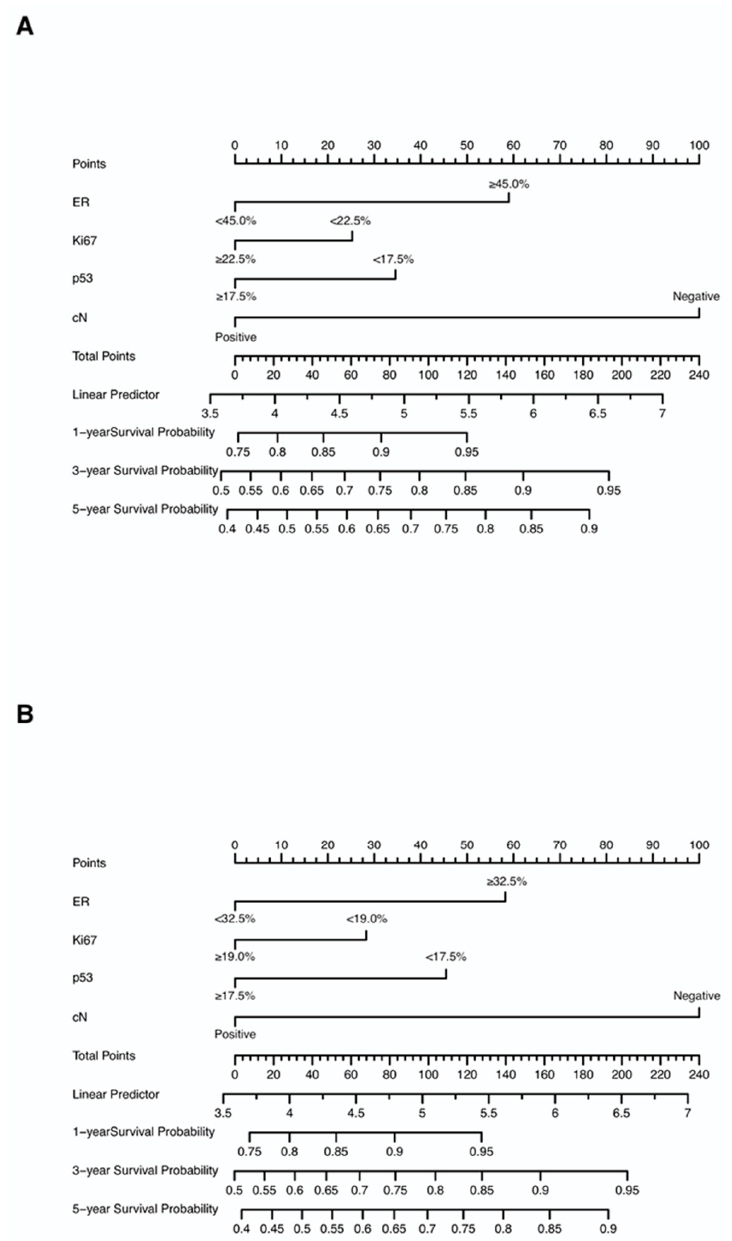
Figure 4. Nomograms predicting the 1-, 3-, and 5-year DFS in non-pCR patients based on ( A ) pre-NAC core needle biopsy and ( B ) post-NAC surgical specimens. Each value of each variable corresponds to some points on the line “Points”; the sum of all points together (Total Points) corresponds to a probability on the lines “1-year Survival Probability”, “3-year Survival Probability”, and “5-year Survival Probability”. Abbreviations: DFS, disease-free survival; pCR, pathologic complete response; NAC, neoadjuvant chemotherapy; ER, estrogen receptor; cN, clinical nodal.